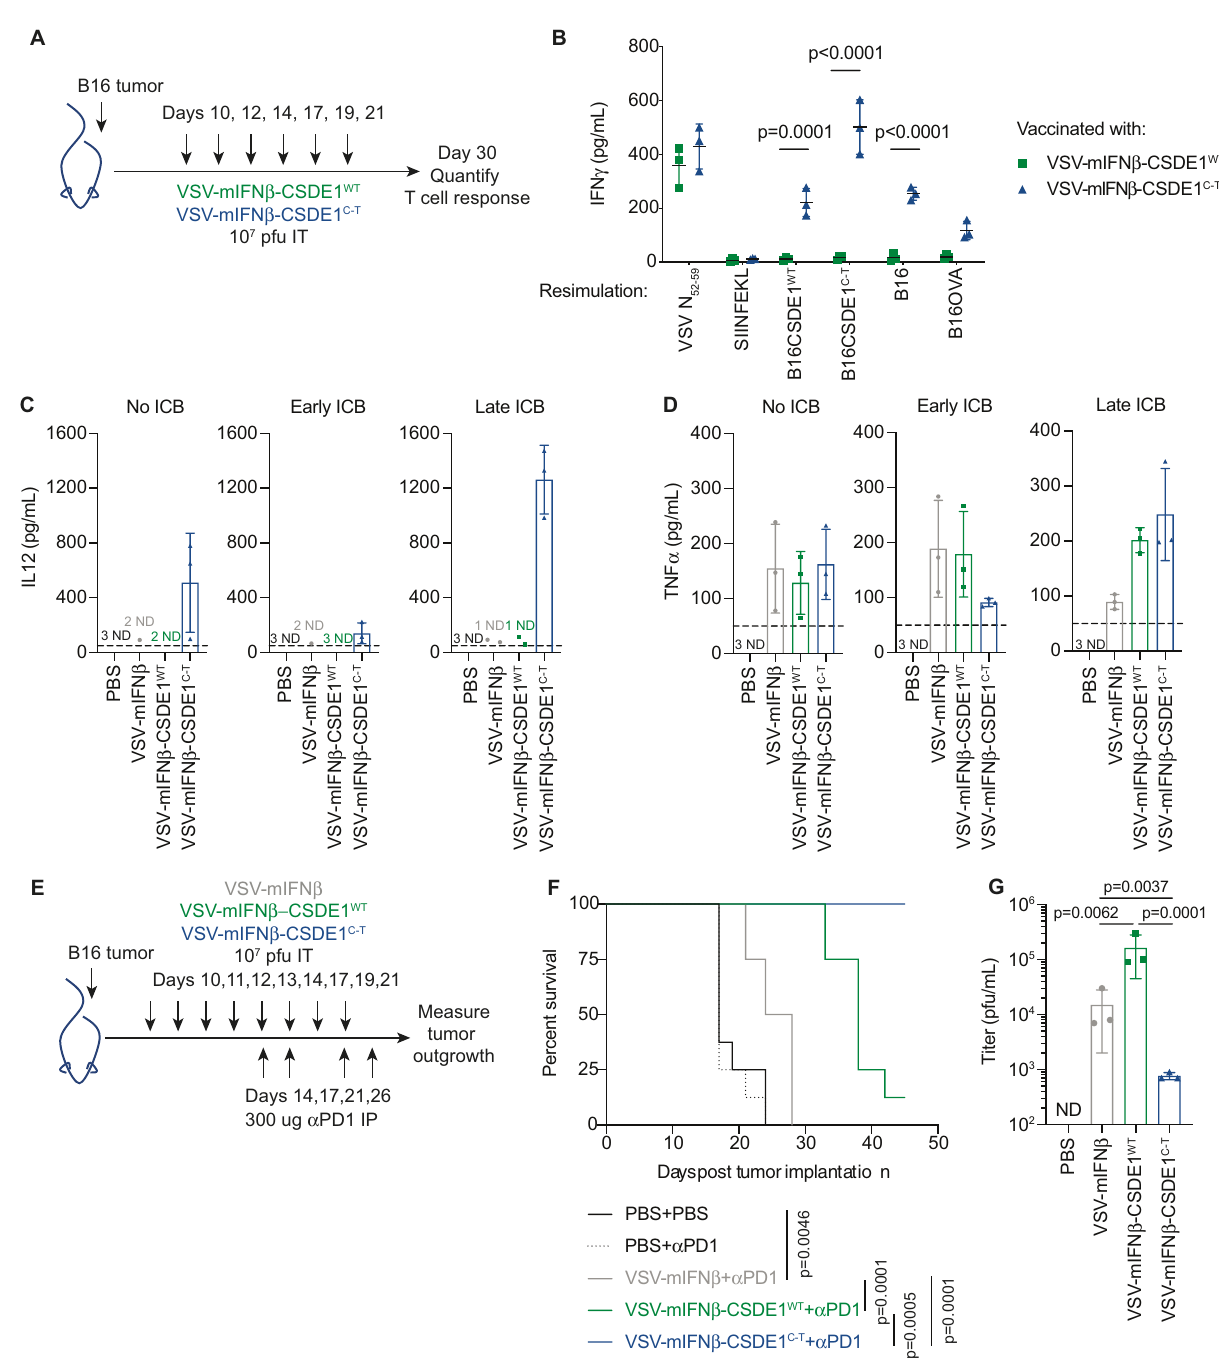
had different baseline reactivity against Hep3B targets, re fl ecting different alloreactivities 11,53 – 55 (Fig. 6A, B). Nonetheless, both APOBEC3B-mutated Hep3B targets and CSDE1 C-T -expressing Hep3B-VSV-hIFN β -ESC cells (Supplementary Fig. 1I) were sig- ni fi cantly more immunogenic than Hep3BP across all three donors (Fig. 6B). Immunogenicity was signi fi cantly reduced by knockdown of CSDE1 46 (Fig. 6B), suggesting that neo-antigenesis of hCSDE1 P5S may serve as an EATA. T cells expanded against Hep3B were unable to kill either Hep3B or Hep3B-VSV-IFN β - ESC targets (Fig. 6C). In contrast, T cells expanded against Hep3B-VSV-IFN β -ESC cells showed signi fi cant cytotoxicity against Hep3B-VSV-IFN β -ESC targets (Fig. 6C) and